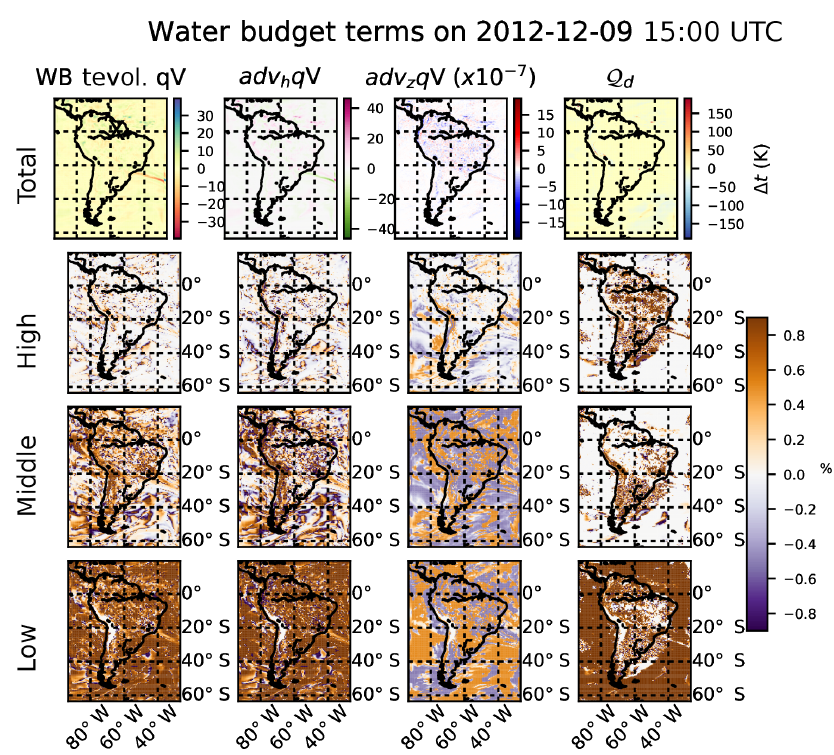
Figure 13. Water vapor budget maps of each component and diabatic heating from microphysics at a given time and the percentage contri- bution at each different vertically integrated layer with respect to the total. Total tendency PW ( ∂ t qv, first column), horizontal advection F (adv h qv, second column), vertical advection Z (adv z qv, third column), and diabatic heating from microphysics ( Q d , fourth column). Percent- age contribution of high-level ( p < 440hPa) integration to the total (second row), percentage for mid-level (680 > p ≥ 440hPa) integration to the total (third row), and percentage of low-level ( p ≥ 680hPa) integration (bottom row).